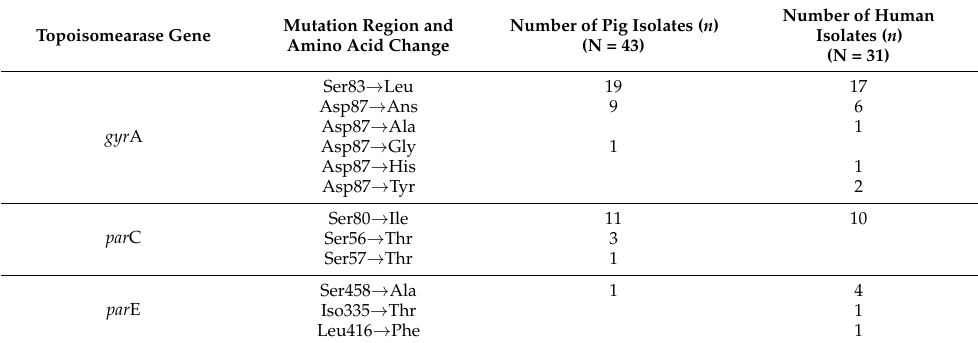
Table 2. Mutations in the quinolone resistance-determining region (QRDR) of ESSBL-producing E. coli from pigs and pig farm